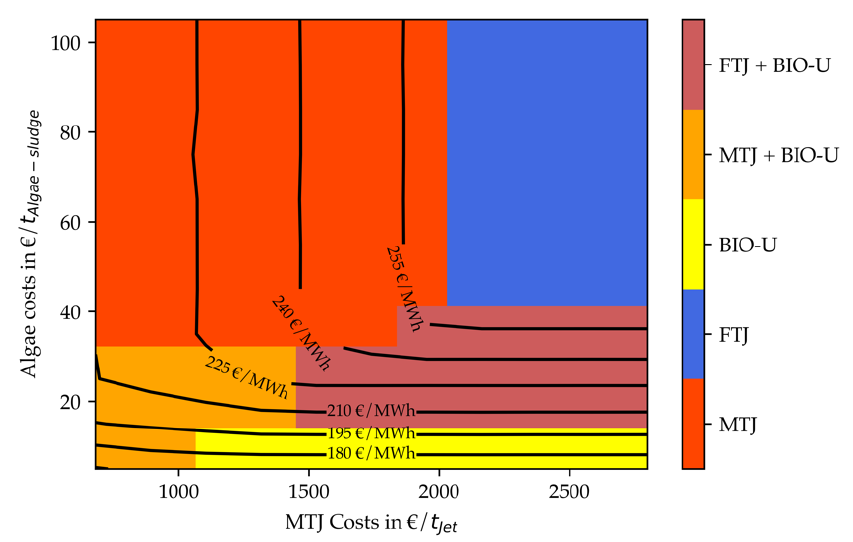
Figure 17. Net production costs (contour lines) and technology choice (heatmap) of optimized renewable refinery depending on algae costs and MTJ costs in scenario 3. Figure 18. Net production costs (contour lines) and technology choice (heatmap) of optimized renewable refinery depending on algae costs and MTJ costs in scenario 4.